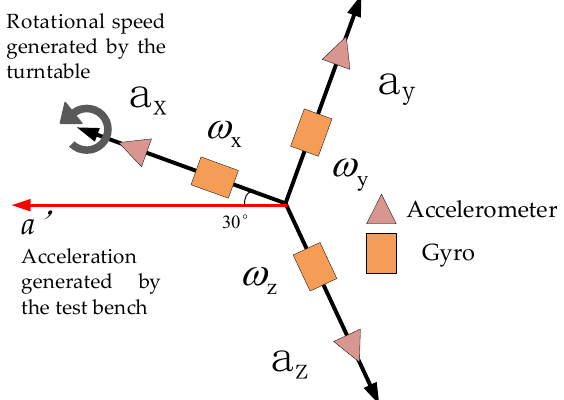
Figure 13. The projectile’s high ‐ rotation and acceleration environment simulation experiment.